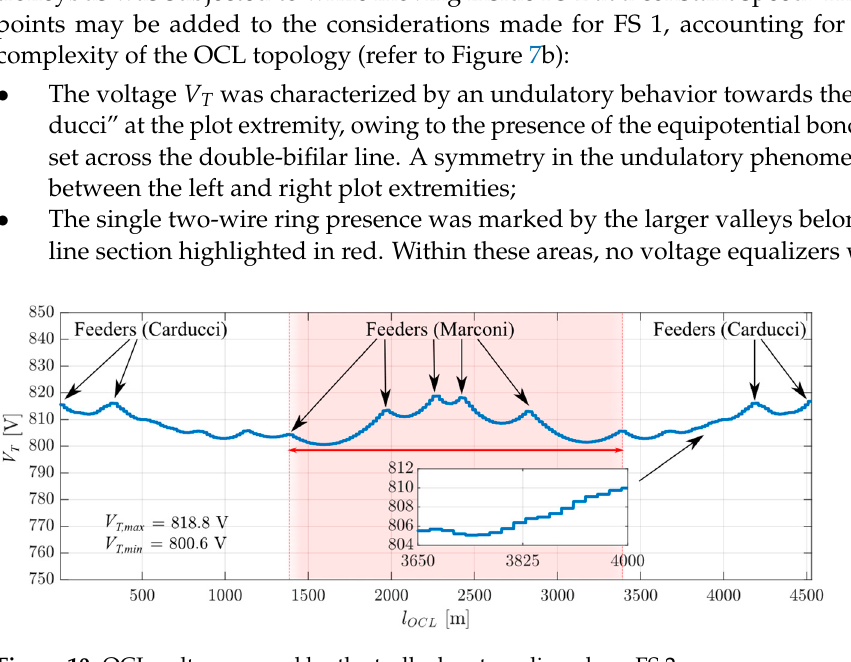
Figure 10. OCL voltage sensed by the trolleybus traveling along FS 2.